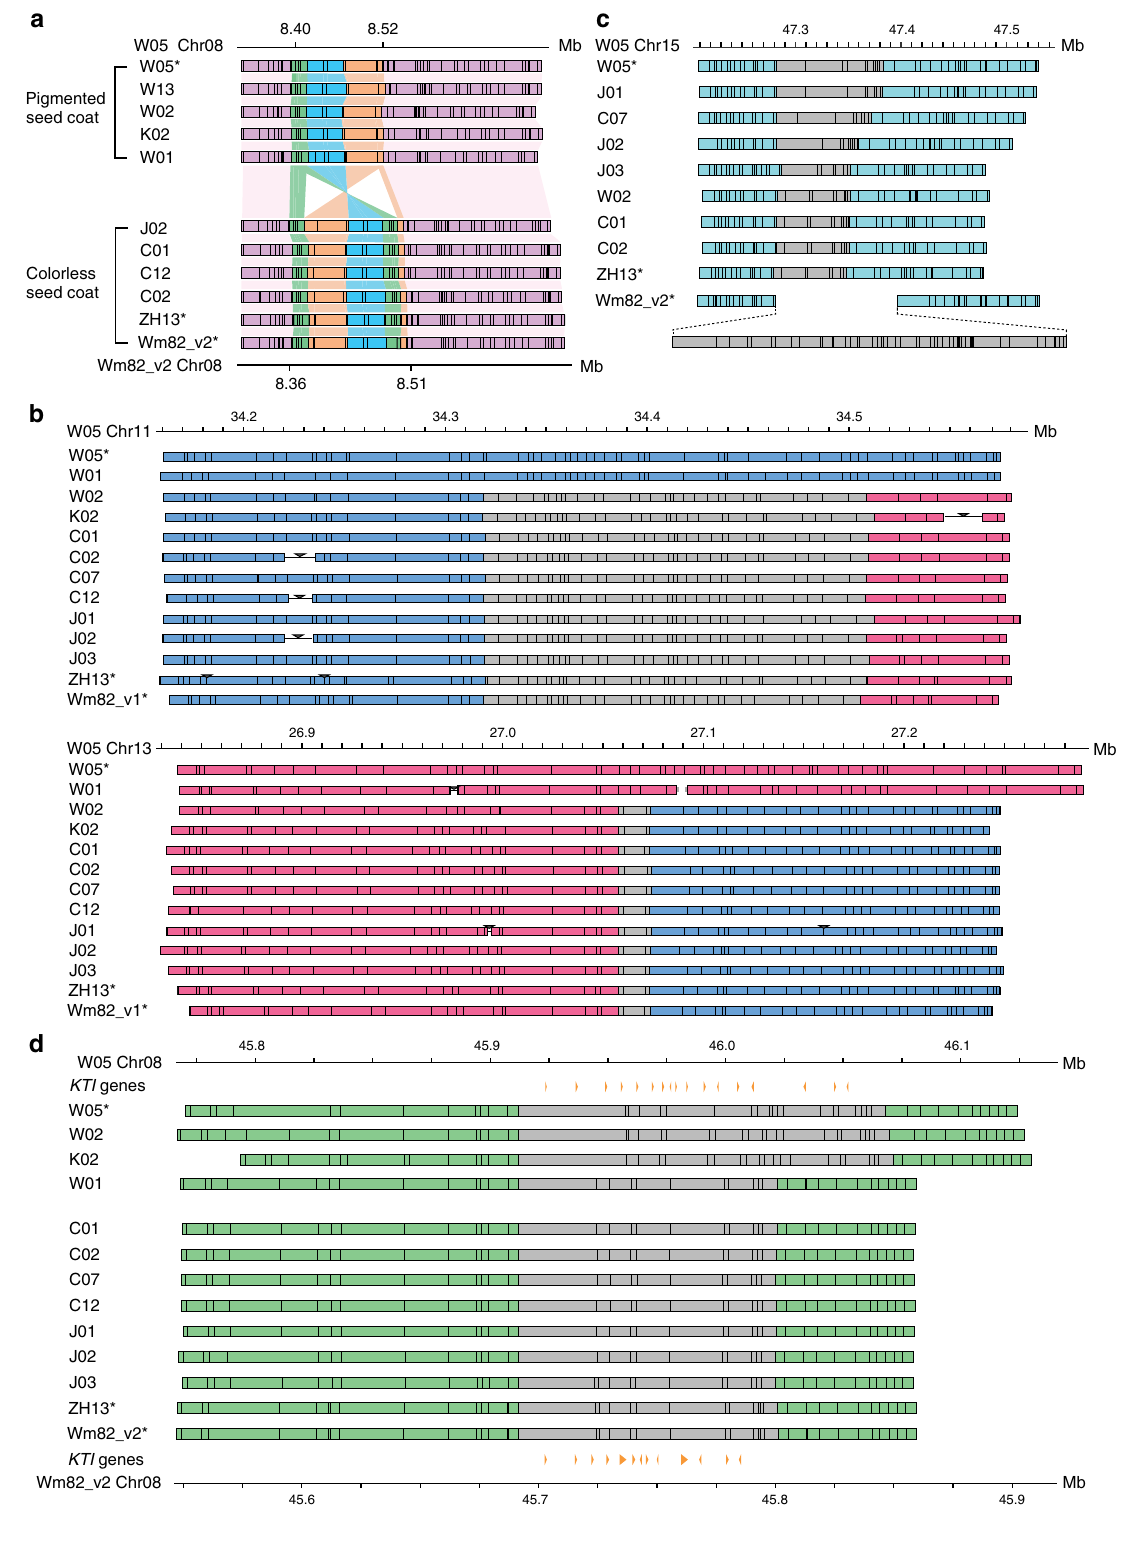
region (Fig. 3d). In the annotated Wm82_v2 and ZH13 reference genomes, there are only 13 and 11 KTI genes, respectively, in this region (Supplementary Figure 7), implying that copy